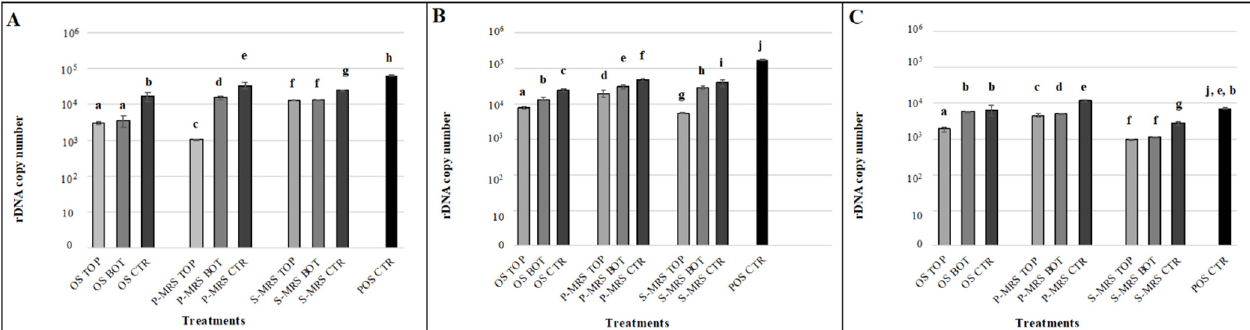
Figure 3. ( A ) Quantitative PCR (qPCR) of a 939 bp target LSU (Large SubUnit) gene; ( B ) a 330 bp target gene (LSU) and ( C ) a 330 bp target gene (actin) of C. antarcticus DNA, after exposure to SVT treatments. On the axis of the ordinates the number of amplified copies on a logarithmic scale is shown; on the abscissa axis, the treatments are as follows: DNA from samples exposed to space simulated conditions (OS) and samples exposed to Mars-like conditions (P-MRS and S-MRS). OS = Original Substrate (sandstone); P-MRS = Phyllosilicatic Mars Regolith Stimulant; S-MRS = Sulfatic Mars Regolith Stimulant. Top (exposed to sun light with 0.1% Neutral Density filters), Bottom (dark control in space, not exposed to space radiation) and CTR (sample kept in the lab, in the dark at room temperature); POS CTR = DNA of C. antarcticus colony growth in physiological conditions (cultivated on MEA and incubated at 15 °C). The same letters above the bars indicate that the values are not statistically significant according to the t test ( p ≤ 0.05). OS = Original Substrate, P-MRS = Phyllosilicatic Mars Regolith Simulant, S-MRS = Sulfatic Mars Regolith Simulant.